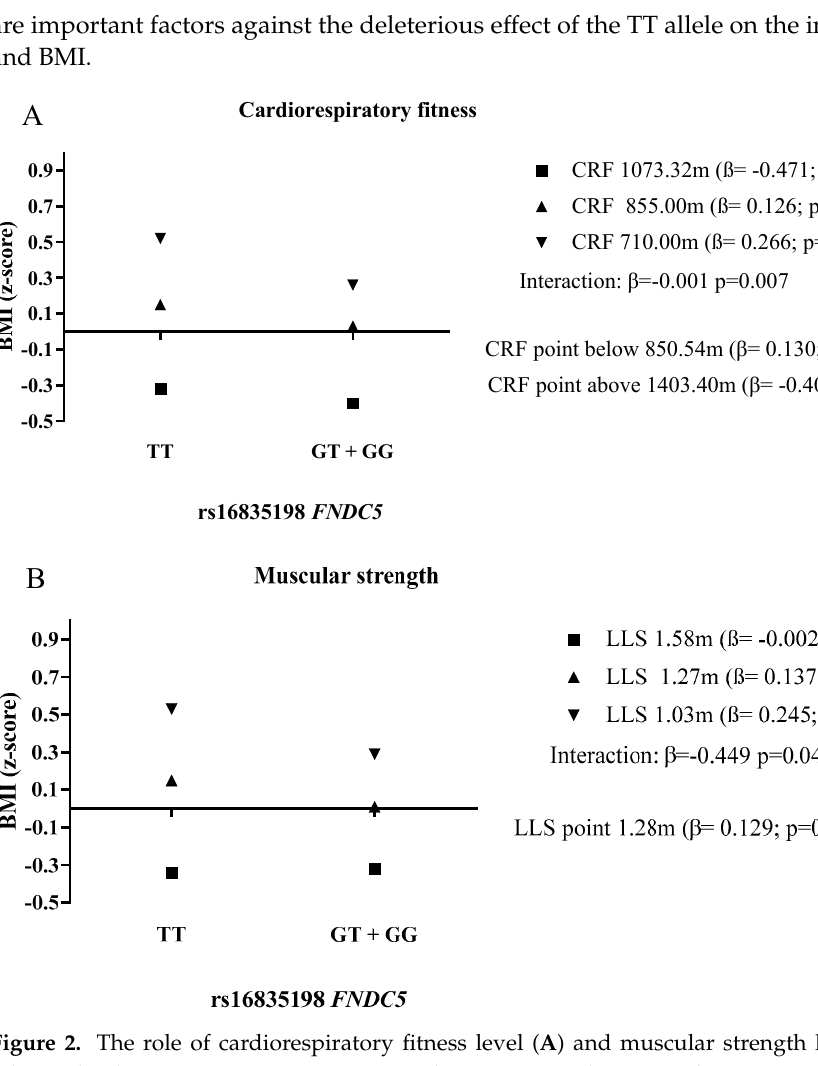
Figure 2. The role of cardiorespiratory fitness level ( A ) and muscular strength level ( B ) in the relationship between rs16835198 FNDC5 and BMI. BMI: Body mass index; CRF: Cardiorespiratory fitness; LLS: Lower limb strength. All analyses were adjusted for age, sex, skin color, living area, and school network.